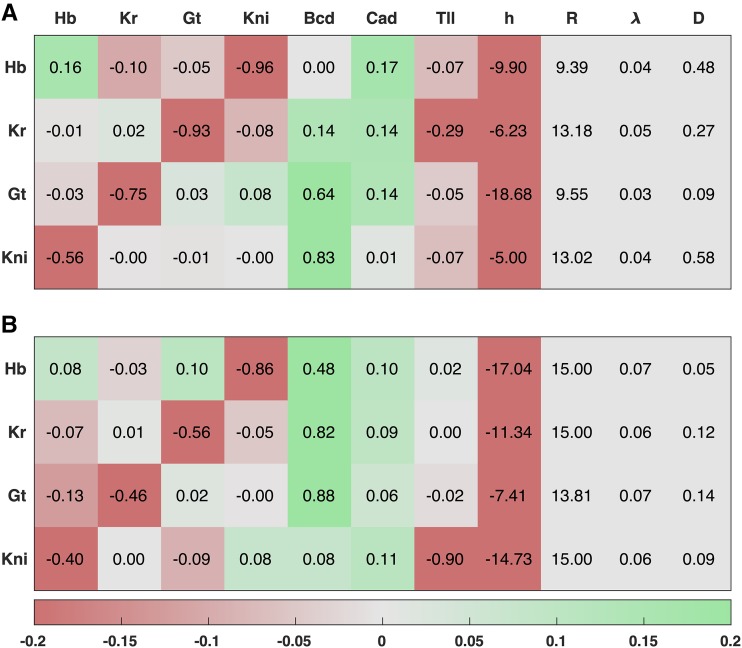
Comparison of gap gene parameters inferred by FIGR and SA. The values of T∼g, h∼g, R∼g, λ∼g, and D∼g are listed one gene per row. The T matrix is shown in the first seven columns, one column per regulator. Green (red) indicates activation (repression). Since Tg and hg can only be determined up to a constant factor, they have been normalized (‖(T∼g1,…,T∼gG,h∼g)‖=1) to allow comparison between FIGR and SA. A. FIGR after refinement. B. SA.